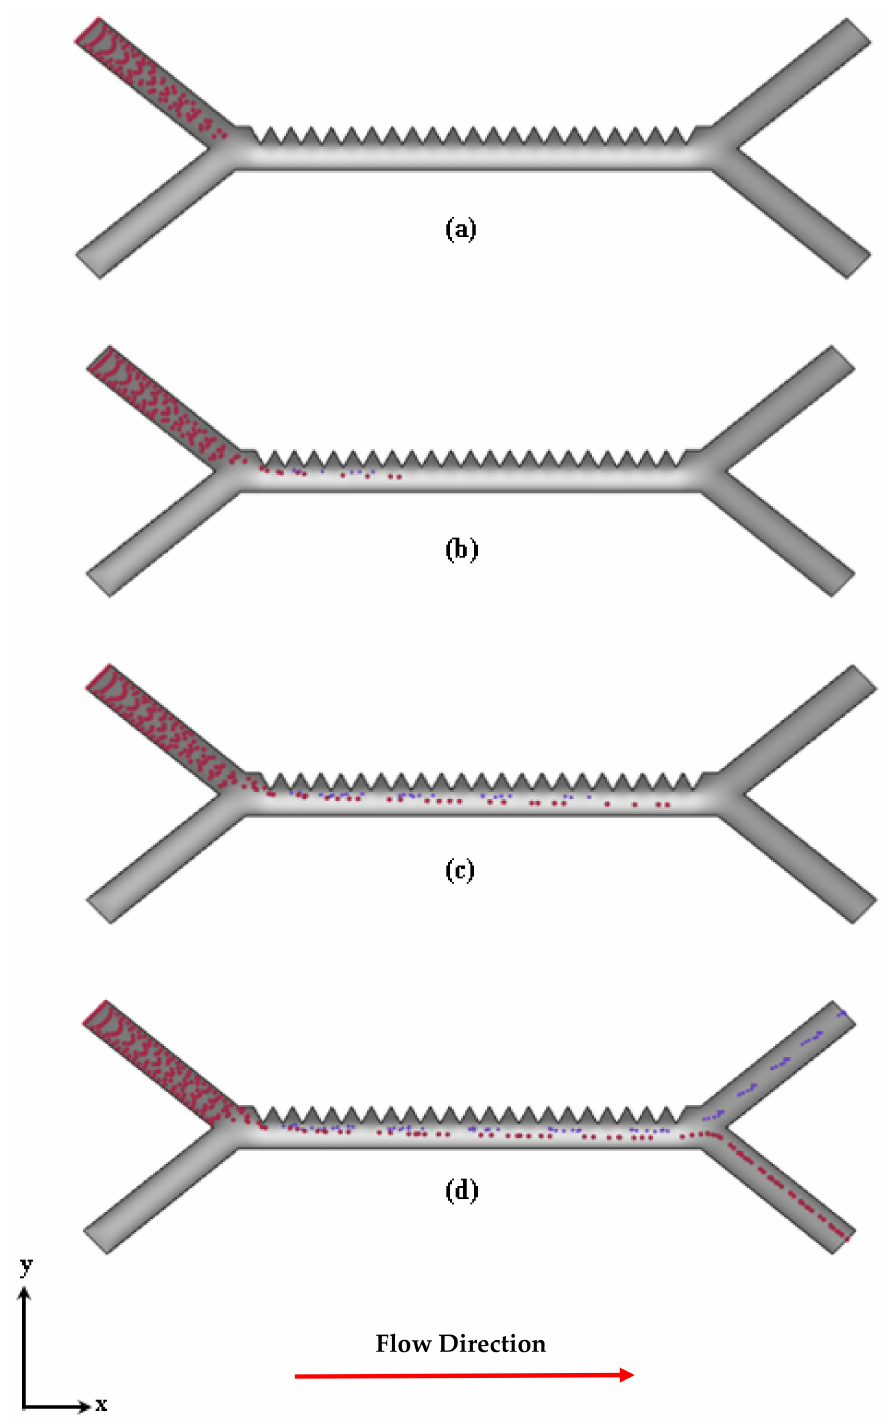
Figure 16. RBC and platelet continuous flow separation tracking at times: ( a ) t = 1 s, ( b ) t = 1.25 s, ( c ) t = 1.5 s, ( d ), t = 2